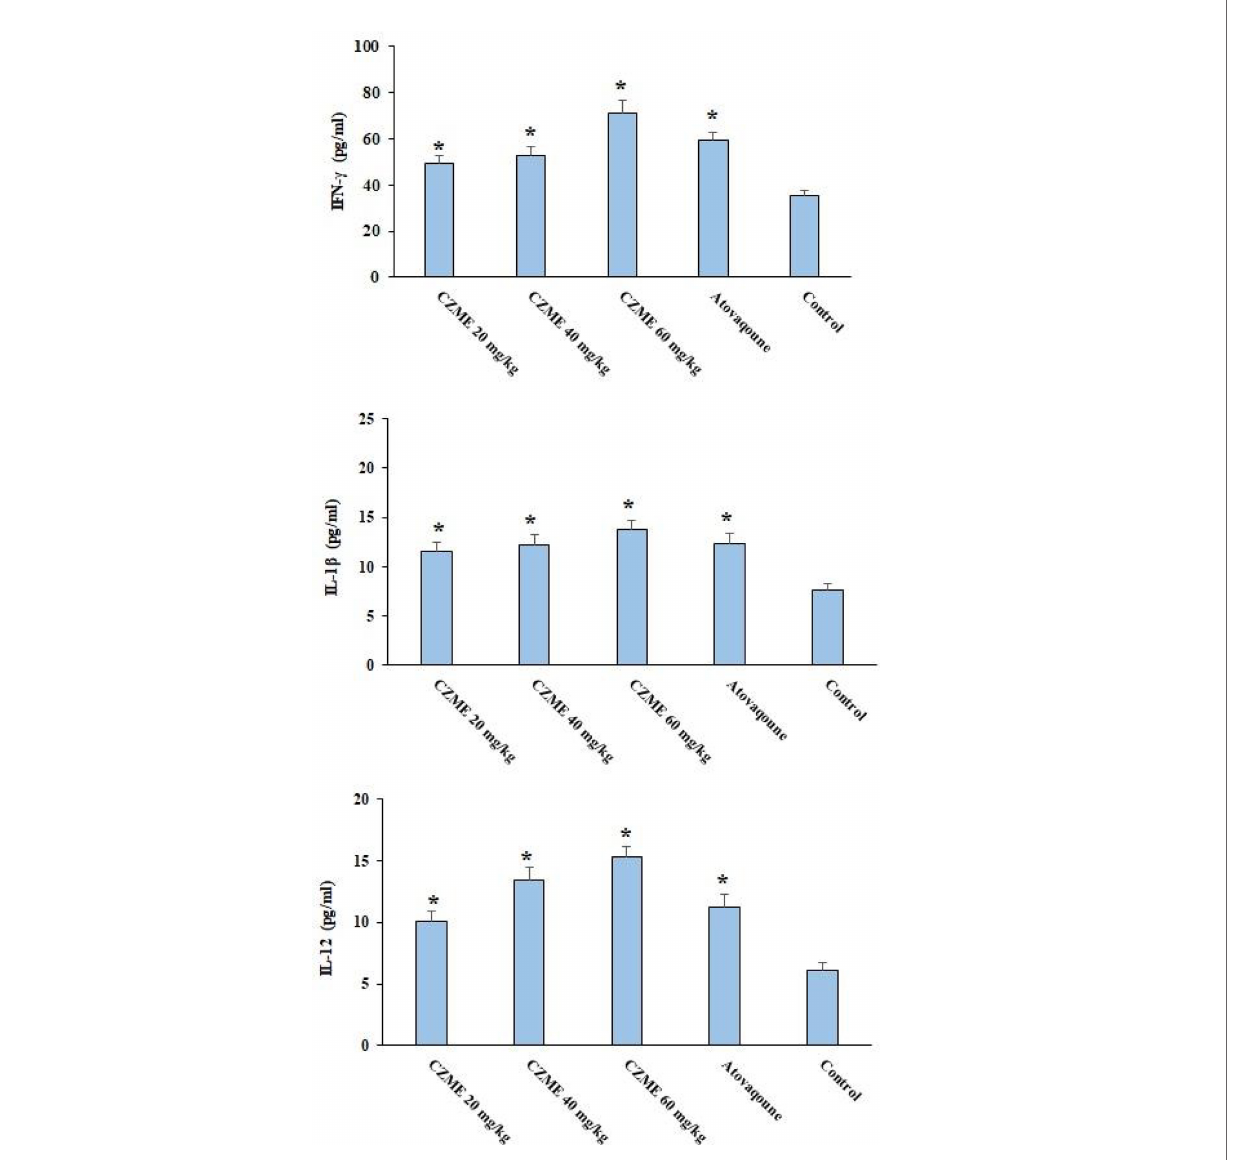
FIGURE 4 | Effect of C. zeylanicum methanolic extract (CZME) on the level of IFN- g , IL-1 b , and IL-12 in the infected mice in comparison with the control groups. Mean ± SD. *p <